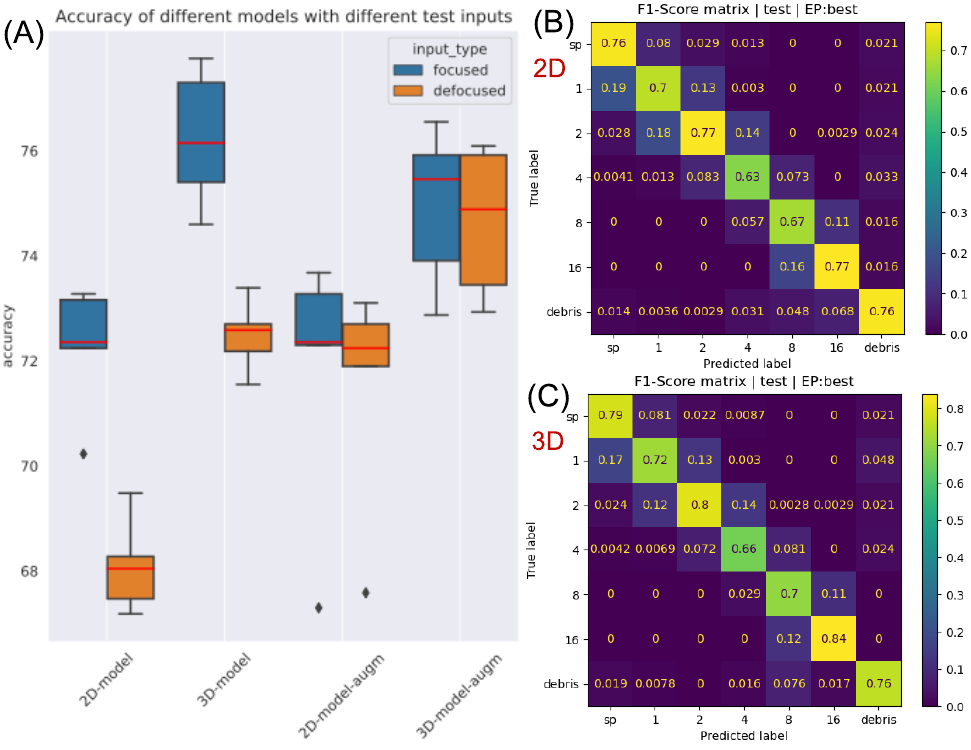
Figure 4. ( A ) Boxplot of the accuracy of the models with different input types; ( B ) F1-score matrix of the 2D-model in the case of in-focus training and test inputs. ( C ) F1-score matrix of the 3D-model in the case of in-focus training and test